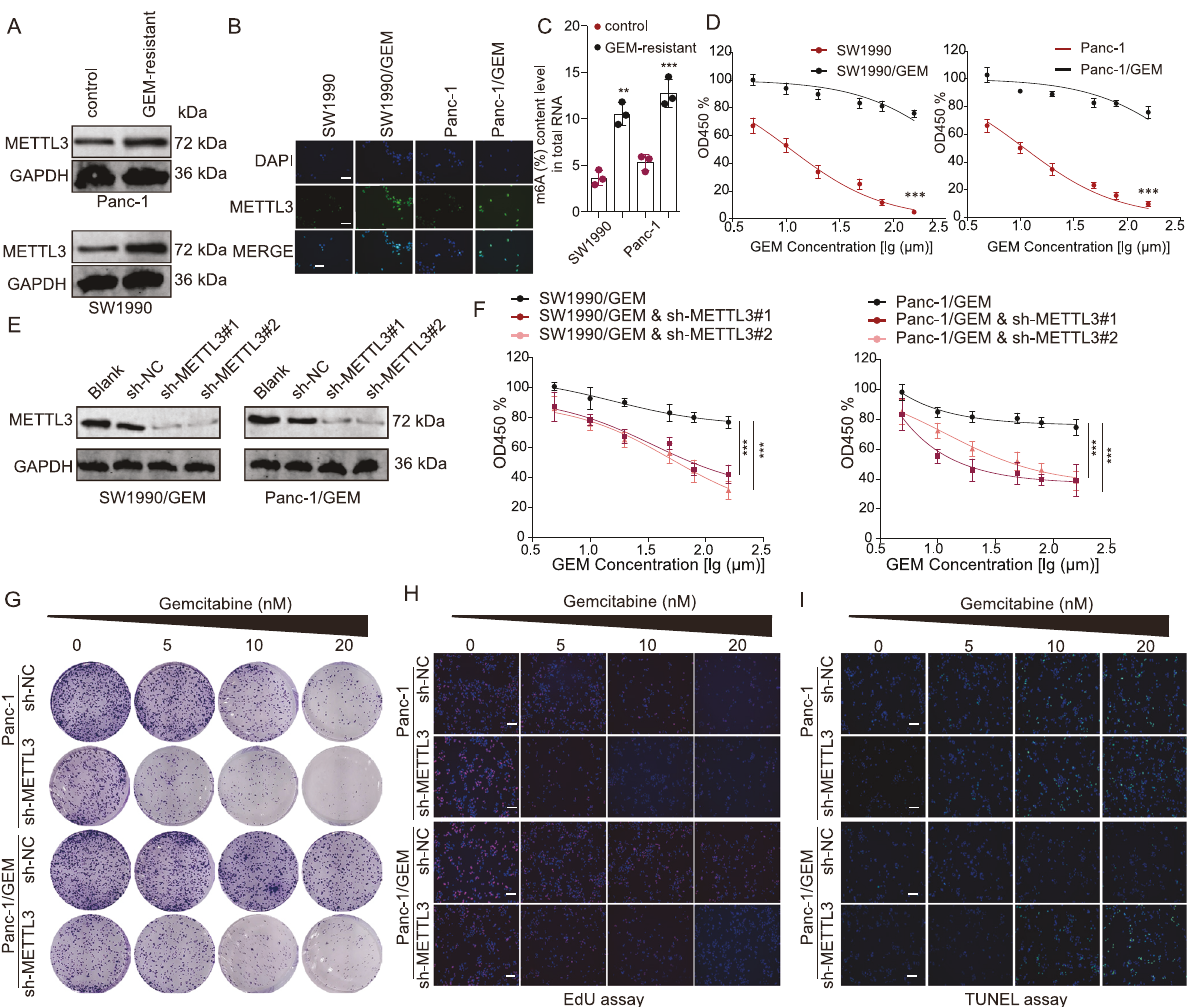
Fig. 1 METTL3 was upregulated in gemcitabine-resistant cells and the knockdown of METTL3 increased the sensitivity to gemcitabine in pancreatic cells. A , B . METTL3 was upregulated in GEM-resistant Panc-1 and SW1990 cells. GEM: gemcitabine. A western blotting assay; B fl uorescence in situ hybridization (FISH) assay. C The m6A level in GEM-resistant Panc-1 and SW1990 cells was signi fi cantly higher than in corresponding parent cells. ** P < 0.01, *** P < 0.001, compared with control group. D Both SW1990 and Panc-1 cell lines were sensitive to GEM treatment in a dose-dependent manner whereas GEM-resistant cell lines did not show signi fi cant changes across the spectrum of doses of gemcitabine. *** P < 0.001, compared with the corresponding parent cell line. E The two shRNAs against METTL3 inhibited the protein expression of METTL3 in both GEM-resistant cell lines. *** P < 0.001, compared with the GEM-resistant cell line. F The knockdown of METTL3 in GEM-resistant cells signi fi cantly increased the sensitivity to gemcitabine treatment and resulted in less cell viability (measured in optical density (OD) at 450 nm). G In both Panc-1 and GEM-resistant Panc-1 cell lines, the knockdown of METTL3 signi fi cantly increased the sensitivity to gemcitabine treatment and led to less colony formation. H In both Panc-1 and GEM-resistant Panc-1 cell lines, the knockdown of METTL3 signi fi cantly increased the sensitivity to gemcitabine treatment and led to less EDU incorporation. I In both Panc-1 and GEM-resistant Panc-1 cell lines, the knockdown of METTL3 signi fi cantly increased the sensitivity to gemcitabine treatment and led to more cell c-myc, cyclin B1, and survivin protein expression in the two cell lines (Fig. 5G). Meanwhile, Transwell and wound healing assay results revealed that DDX23 knockdown led to suppressed migration and invasion of the two cell lines by approximately 50% (Fig. 5H, I). Furthermore, the protein level of DDX23 was signi fi cantly higher in GEM-resistant cell lines compared with the parent cell lines (Fig. 5J). Subsequently, we carried out colony formation and TUNEL assays to learn the effects of DDX23 knockdown in GEM-resistant cell lines. Not surprisingly, in both the parent and GEM-resistant Panc-1 cell lines, DDX23 knock- down resulted in signi fi cantly suppressed colony formation (Fig. 5K) and increased apoptosis (Fig. 5L) in synergy with GEM treatment of different concentrations.